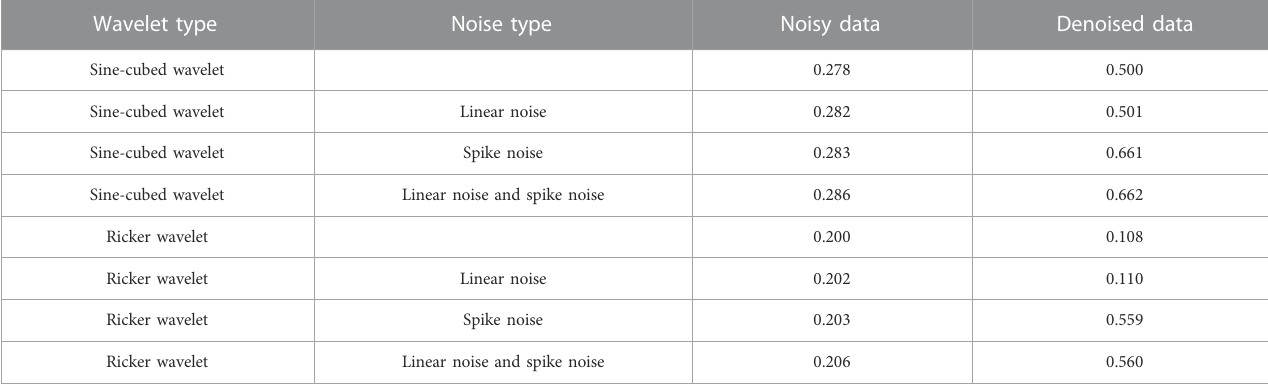
TABLE 3 Denoising performance on different types of noises and wavelet (in terms of